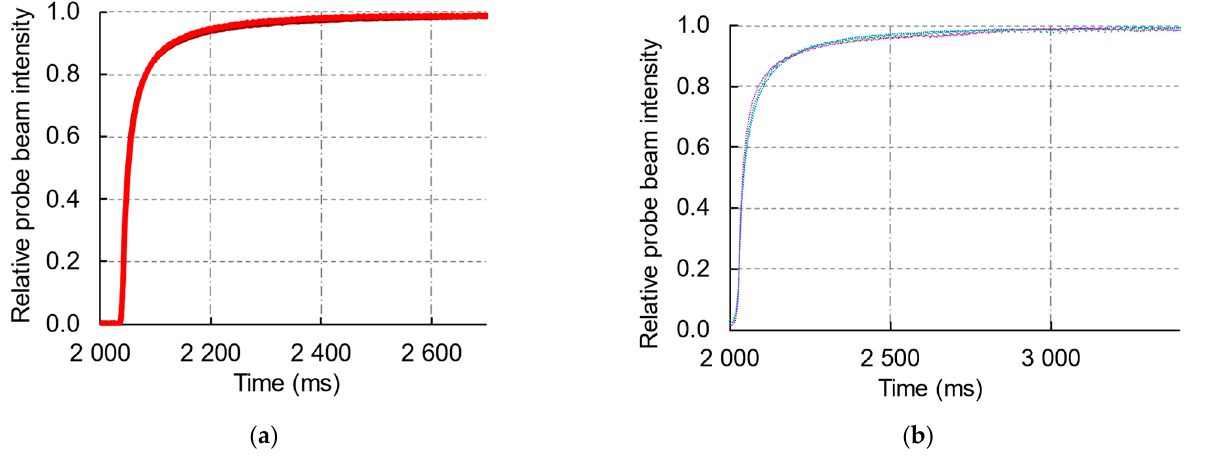
Figure 11. Normalized averaged transient thermal-lens dissipation curves ( a ) for ferroin (red line) and hemoglobin cyanide (dark red line) with the same absorbance in 3 M NaCl; ( b ) albumin solutions of various concentrations (no albumin, green; 20 g/L, blue; and 50 g/L, magenta) with the addition of ferroin (10 µM in a solution of 0.9% NaCl); for clarity, the X-axis is shown in the logarithmic scale. Setup, excitation wavelength, 514.5 nm; excitation power, 40 mW. The delay of the dissipation start is caused by closing the mechanical shutter.